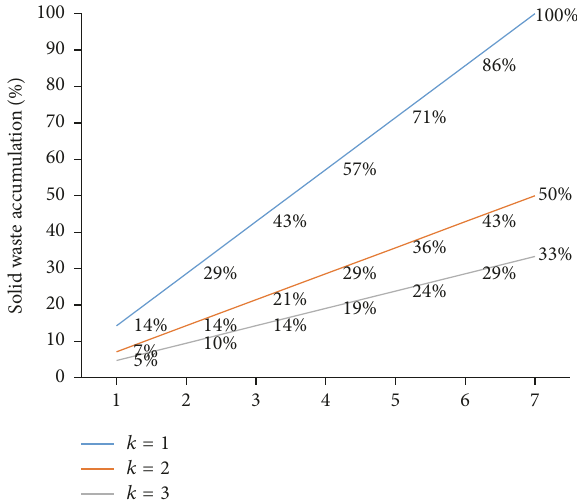
Figure 2: Solid waste accumulation per day 𝑡 for 𝑝 = 1,...,6 and 𝑘 = 1,2, 3 .